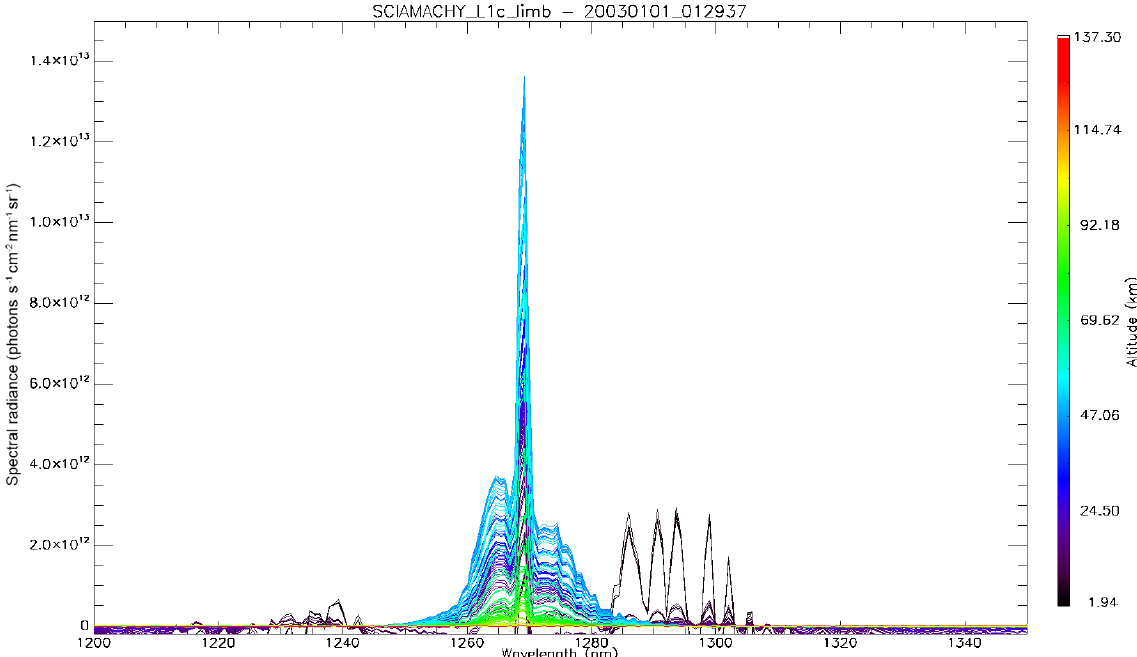
Figure F4. Airglow spectra obtained from Fig. F3 by subtracting a linear interpolation based on the two constant values of the continuum (one on each side) estimated from the median value of all points outside the O 2 ∗ band. This correction is valid above ∼ 20km tangent altitude.